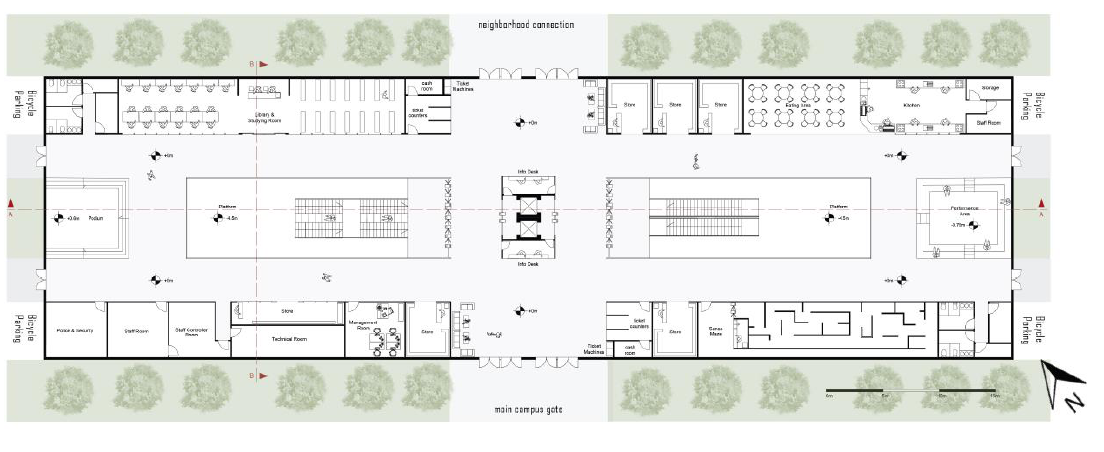
Figure 10 Design suggestion where the designer suggested a micro-mobility center research for the city with research areas and interactive surfaces (Görkem Kemal Genç)